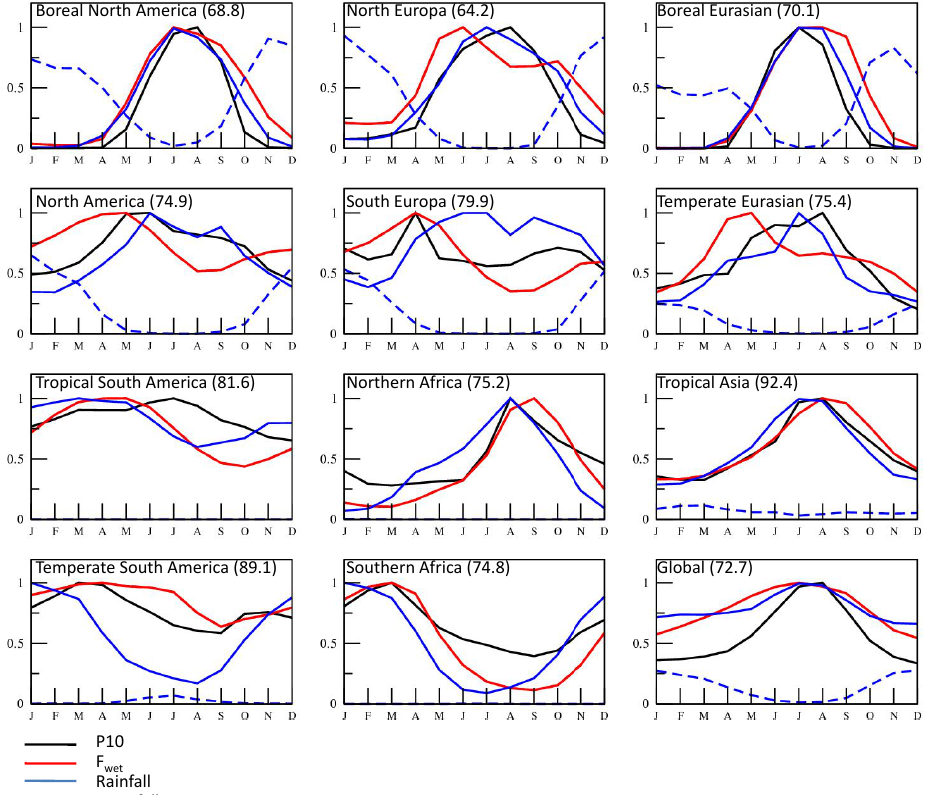
Fig. 7. Mean seasonal cycle for each region and at global scale for P10 and F wet . Seasonality of snowfall and rainfall (both in relative way compared to snowfall + rainfall) are also added. All the curves are divided by their maximum value to obtain the same upper limit for all the curves. The FMT between P10 and F wet (see Appendix for FMT definition) is given in each region’s